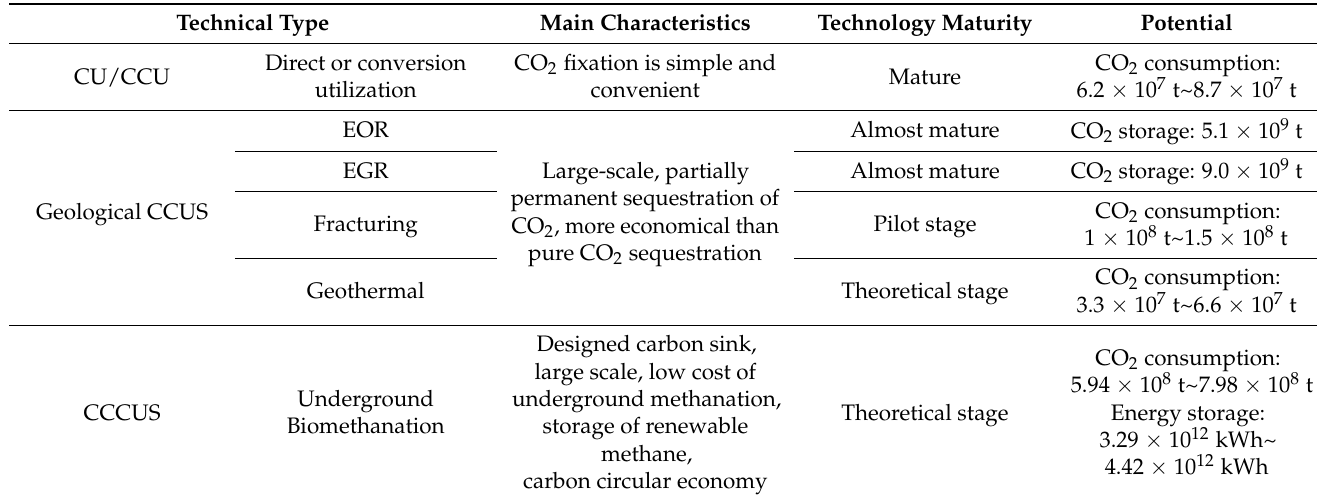
Table 2. Characteristics and potentialities of various technologies in